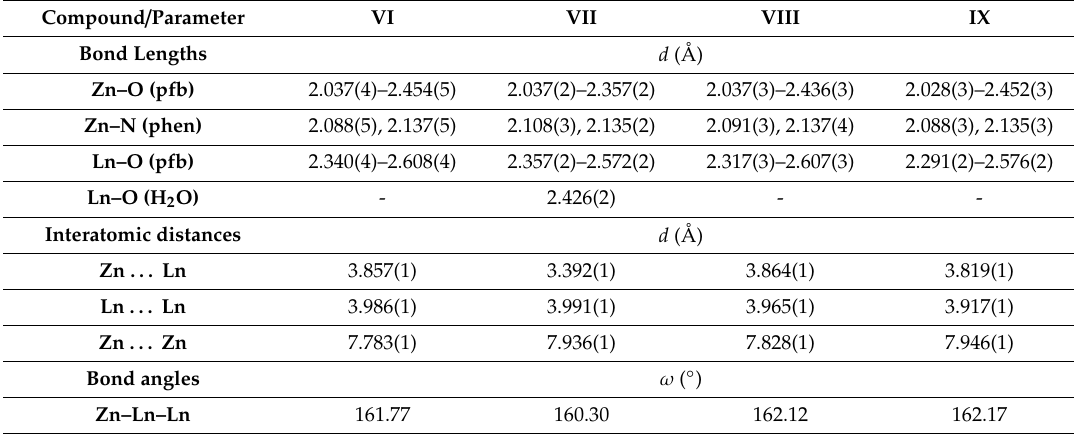
Table 2. Selected bond lengths, the shortest interatomic distances d (Å) and angles ω ( ◦ ) in structures